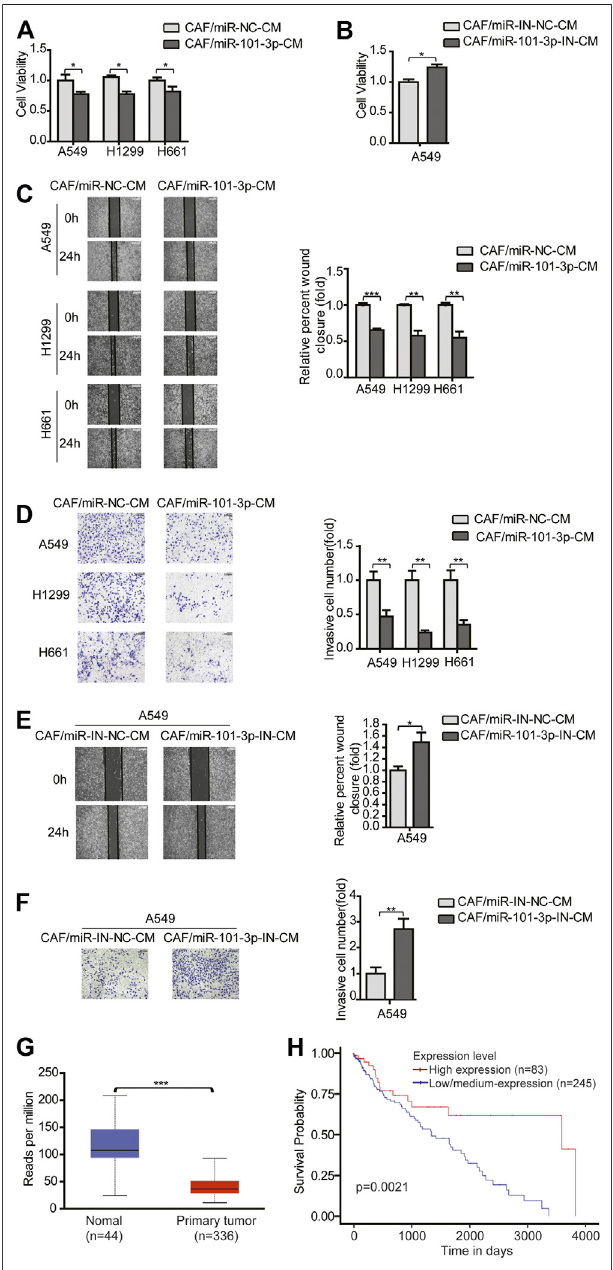
FIGURE 3 | MiR-101-3p mediated the effect of CAFs on migration and invasion of NSCLC cells (A,B) CAFs were transfected with 100 nM of miR- 101-3p mimics or inhibitor. CM was collected and cultured lung cancer cells. Lung cancer cell viability was examined by CCK-8 kit. (C,D) CAFs were transfected with miR-101-3p mimics. CM was collected and culture lung cancer cells. Cell invasion was detected by wound healing assay, and cell migrationwasexamined bytranswell assay. (E,F) CAFsweretransfectedwith miR-101-3p inhibitor. Cell invasion was detected by wound healing assay, and cell migration was examined by transwell assay. (G) MiR-101-3p expression innon-tumorspecimens( n (cid:2) 44)and NSCLCspecimens ( n (cid:2) 336) based on TCGA database. (H) OS rate in NSCLC patients divided into high and low/medium expression of miR-101-3p ( n (cid:2) 328) based on TCGA